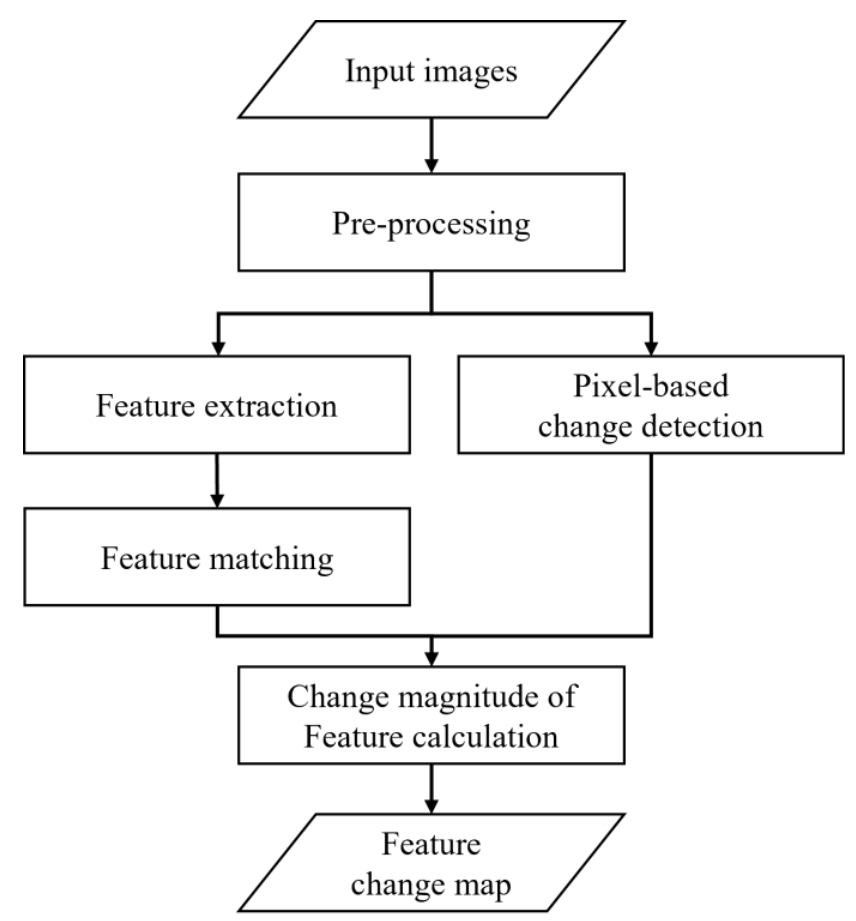
Figure 1. Workflow of the proposed feature-based change detection method.